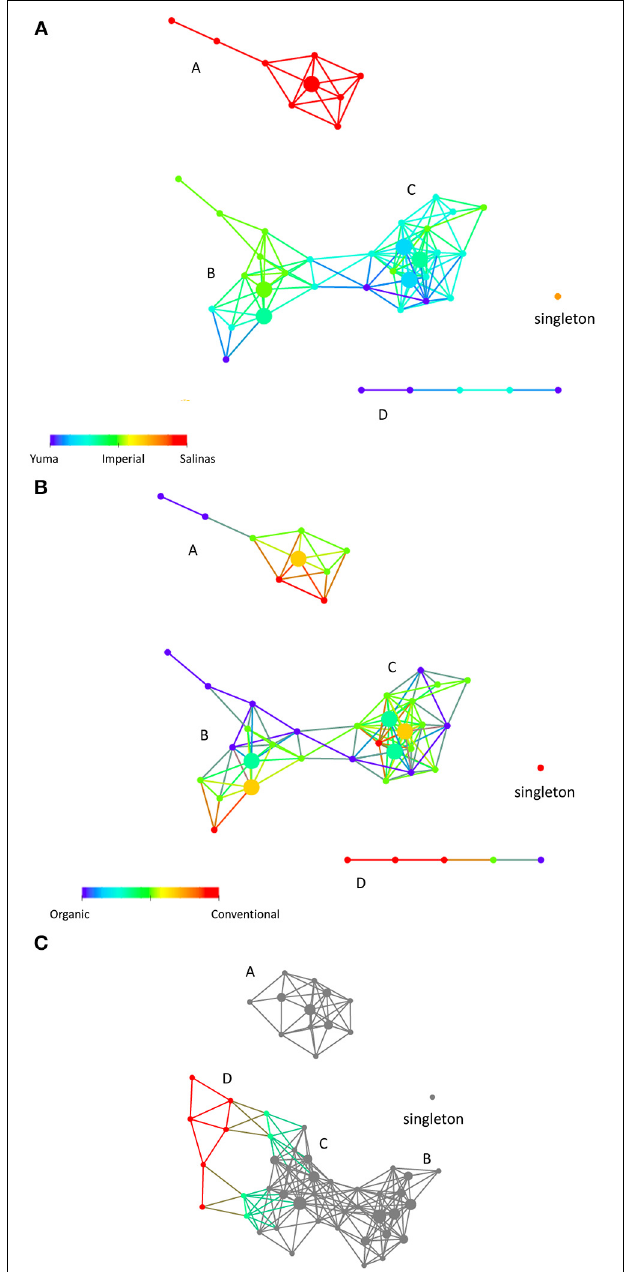
FIGURE 1 | (A) Sample-sample relationships in a topological network. Using physical, chemical, and biological characteristics of the samples, we obtained a network that comprised of 4 sub-networks (A–D) and a singleton (single node comprising of 2 samples). The coloring here is by location, where each location is given a color (Salinas is red, Imperial Valley is green and Yuma is blue). Nodes that have a mixture of soils have colors in between as depicted in the color bar. Sub-networks structure indicates that physical, chemical, and biological characteristics primarily segregate the samples according to location, with Salinas being most different from soils from Yuma and Imperial Valley, (B) . The same network is colored by soilmanagement type (organic (represented by 0) vs. conventional (represented by 1). The red nodes represent samples with conventional